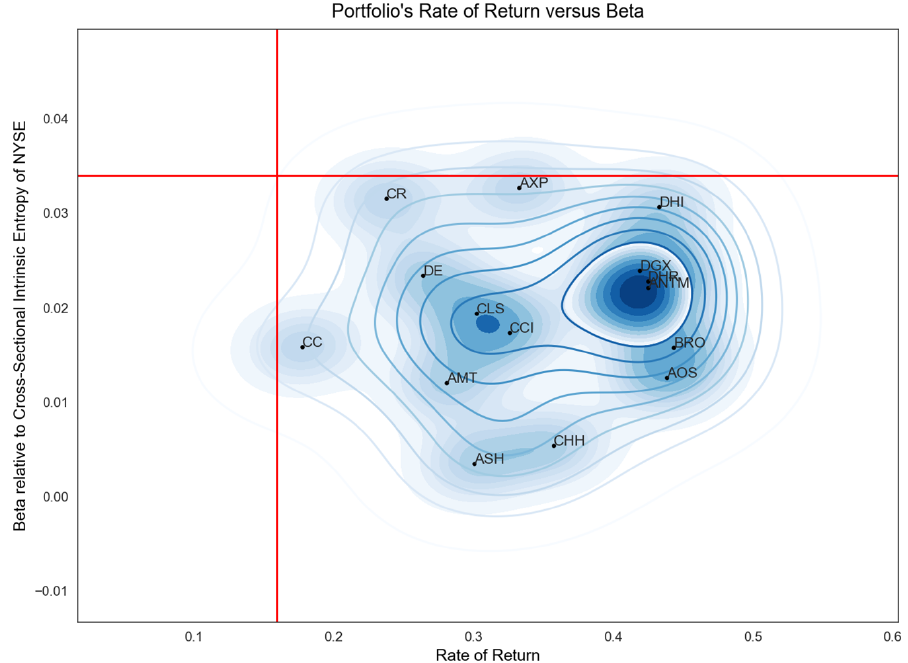
Figure A2. A set of 15 NYSE symbols that outperformed the DJIA index in terms of rate-of-return without being exposed to higher risk (250-day trading interval, from 5 October 2020 to 20 December 2021).